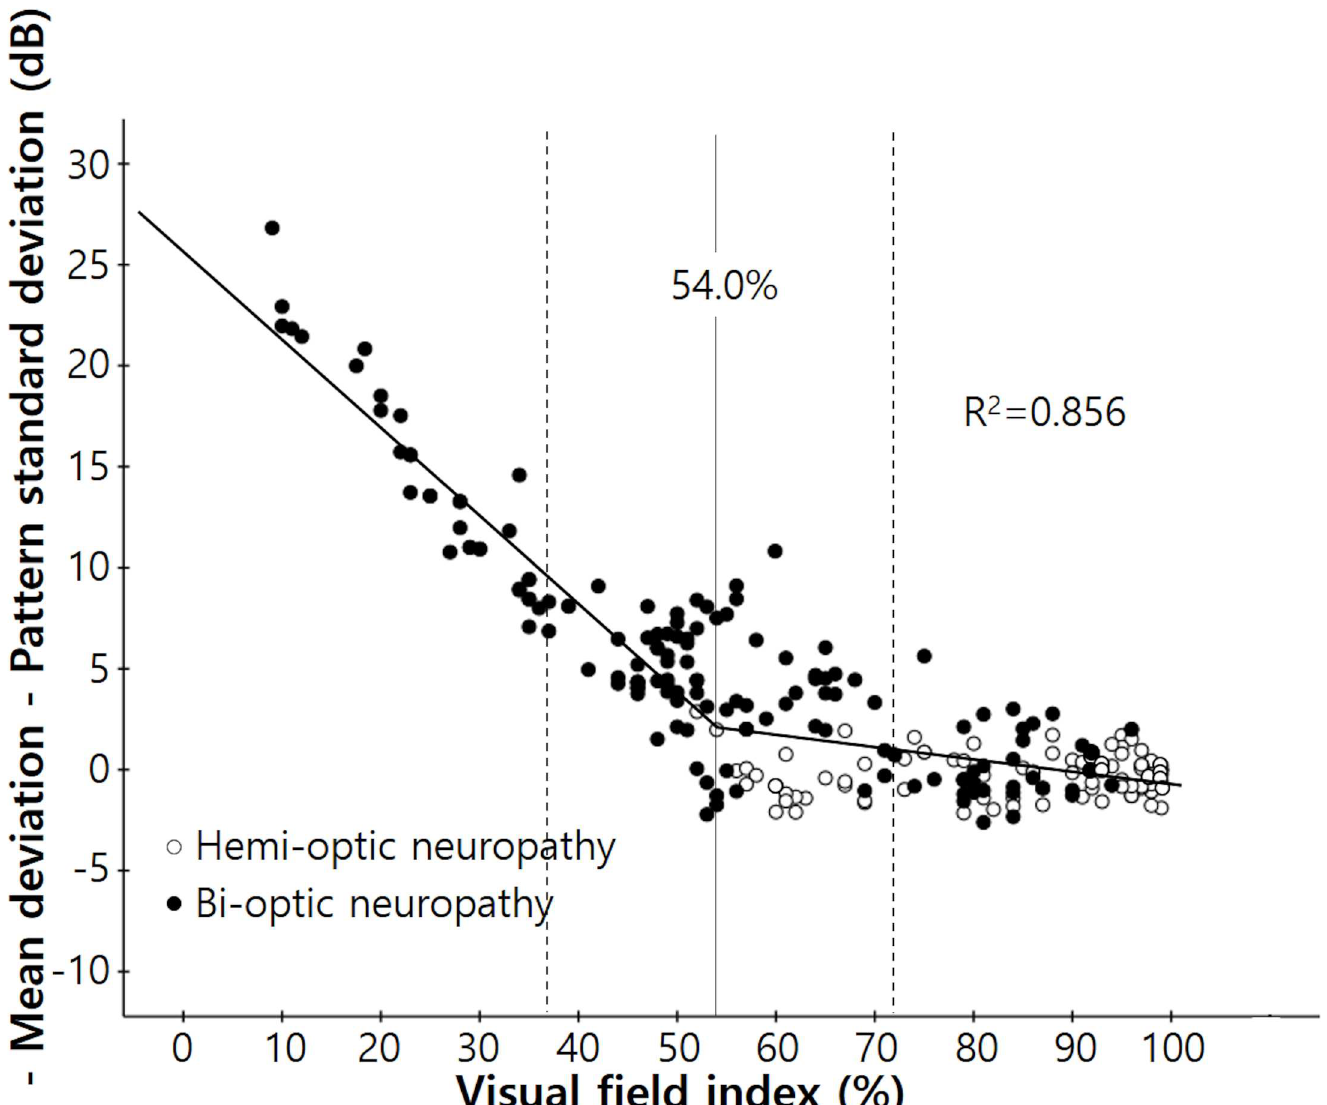
Fig 6. Scatterplot of the difference between the negative MD and PSD values according to the visual field index of enrolled patients. The ‘broken stick’ model is indicatedby the black line. The tipping point was 54.0% (95% confidenceinterval, 36.8~71.2%, P < 0.001); the slope belowthe tipping point was given by Y = 25.747 − 0.437X and the slope abovethe tipping point by Y = 5.551 − 0.063X ( P <